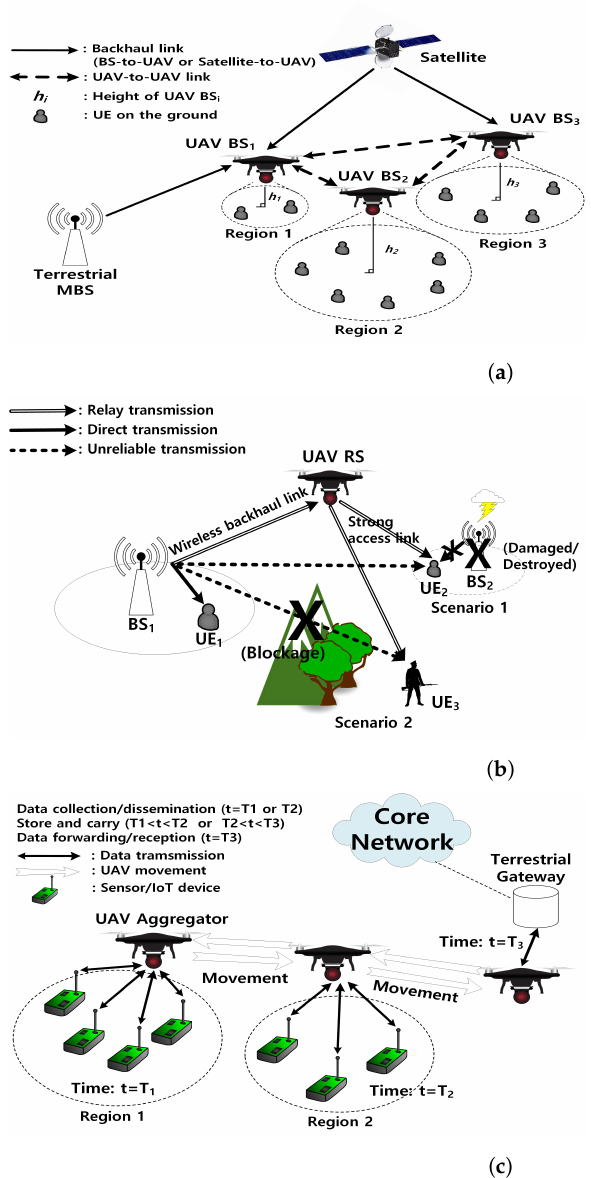
Figure 1. UAV Use Cases. ( a ) UAV base station: Multiple UAVs can cover the emergency or disaster area as aerial BSs where no terrestrial BS is available. A terrestrial MBS or a satellite can provide wireless backhaul links to UAV BSs, and UAV BSs can adjust their positions for performance maximization of networks utilizing UAV-to-UAV links. Note that the coverage area of aerial UAV BSs varies with the altitude of UAVs. ( b ) UAV relay station: UAV RS can extend a terrestrial BS coverage by utilizing a strong air-to-ground LoS link. Scenario 1 considers UE 2 , who cannot be served by BS 2 due to natural disaster or destroyed infrastructure. The distant BS 1 cannot provide a reliable communication link to UE 2 due to severe pathloss attenuations. UE 3 in Scenario 2 cannot have a direct link from BS 1 due to severe blockage. For both scenarios, UAV RS can provide a reliable communication link to UE 2 or UE 3 , where it receives a signal from BS 1 through a wireless backhaul link, and then forwards the received signal to UE 2 or UE 3 via a strong air-to-ground LoS access link. ( c ) UAV aggregator: UAV aggregator flies over sensors or IoT devices to collect data from or disseminate information to them. The mobility of UAV and delay-tolerant transmission (i.e., store-carry-and-forward transmission) can save the transmit power at sensor/IoT devices. A reliable data delivery from sensor/IoT devices to core network is guaranteed, and vice